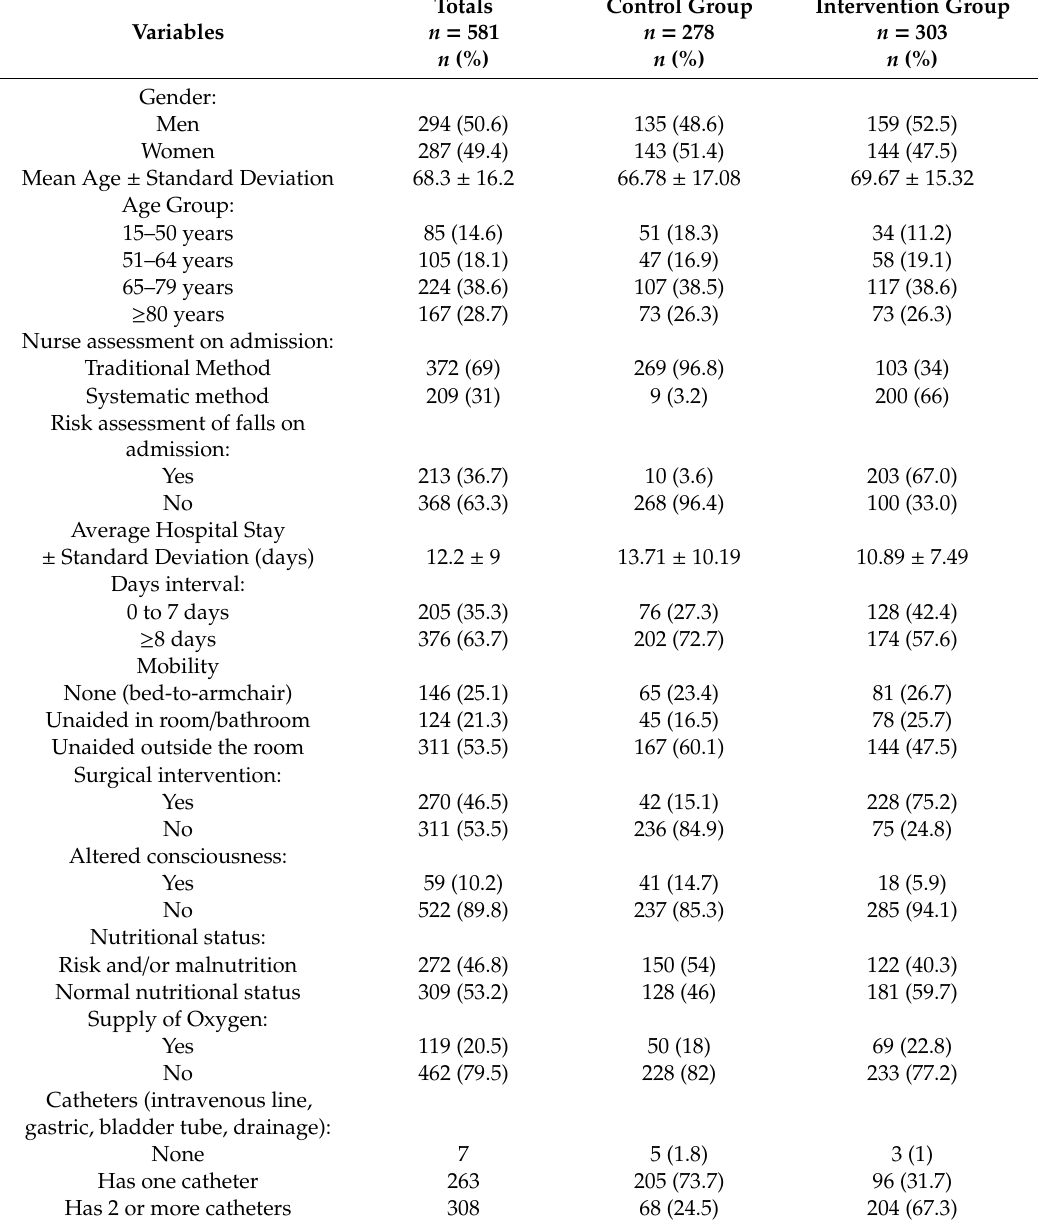
Table 1. Sample description by Study